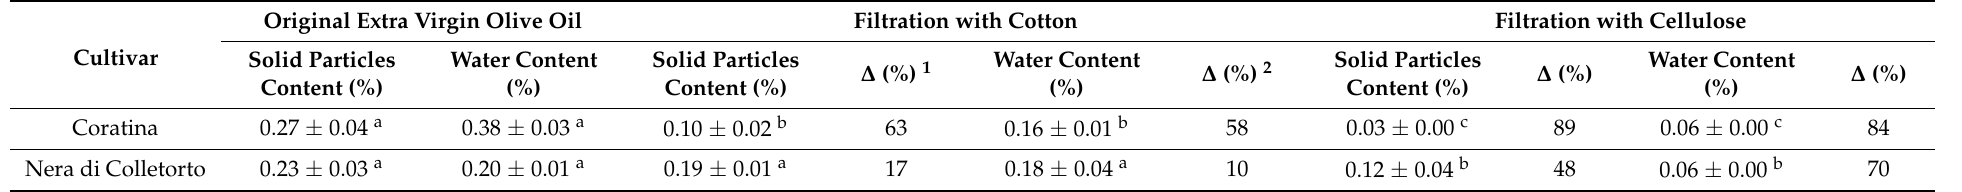
Table 1. Solid particles and water content decay of two freshly produced monocultivar extra virgin olive oil samples subject to filtration.